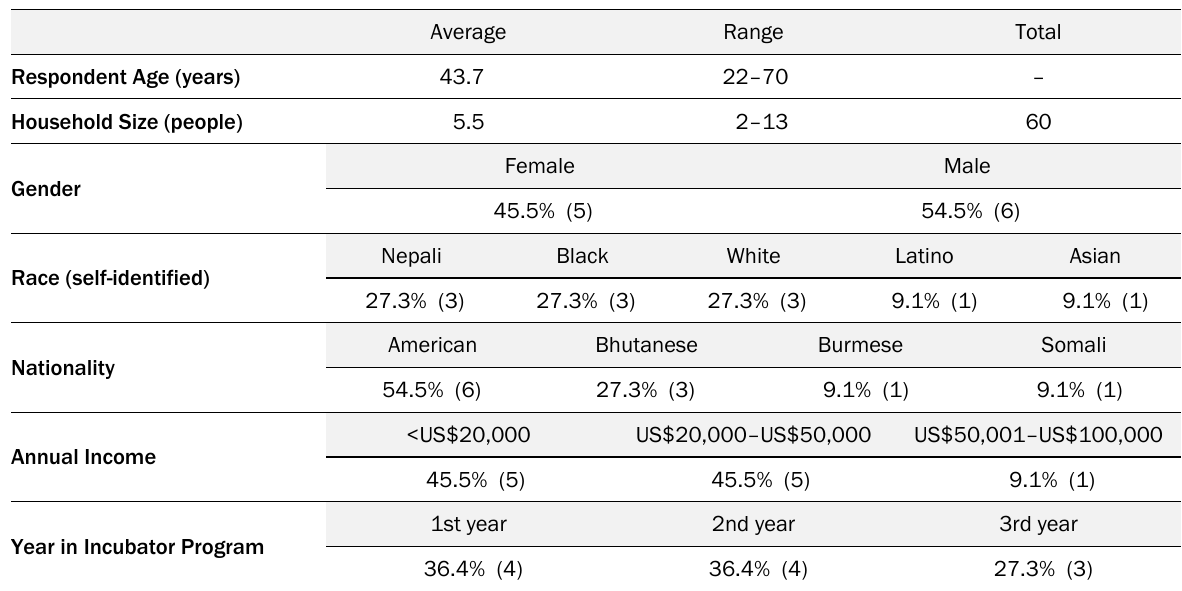
Table 1. Respondent Farmer